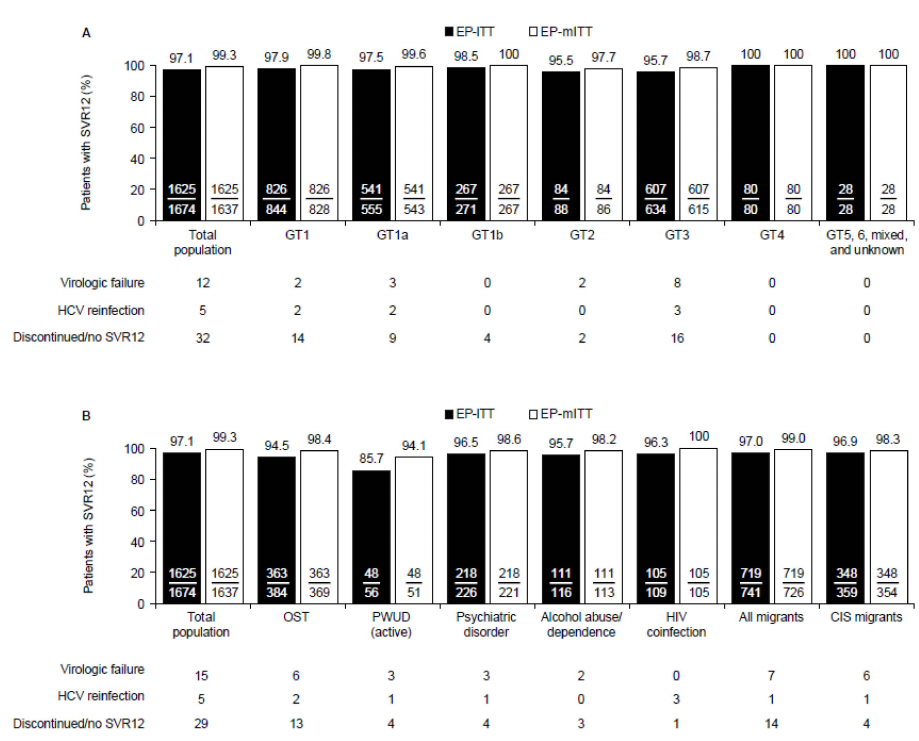
Figure 3. SVR12 rates among TN patients who received GLE/PIB for 8 weeks according to ( A ) HCV genotype and ( B ) key comorbidities and migrant status. Patients who discontinued GLE/PIB prematurely and achieved SVR12 were counted as virologic responders ( n = 11). EP-mITT analysis excluded patients who discontinued GLE/PIB prematurely and did not achieve SVR12, or patients with HCV reinfection. CIS, Commonwealth of Independent States (Armenia, Azerbaijan, Belarus, Kazakhstan, Kyrgyzstan, Moldova, Russia, Tajikistan, and Uzbekistan); EP, effectiveness population; GT, genotype; HCV, hepatitis C virus; HIV, human immunodeficiency virus; ITT, intention to treat; mITT, modified intention to treat; OST, opioid substitution therapy; PWUD (active), people who actively use drugs; SVR12, sustained virologic response at